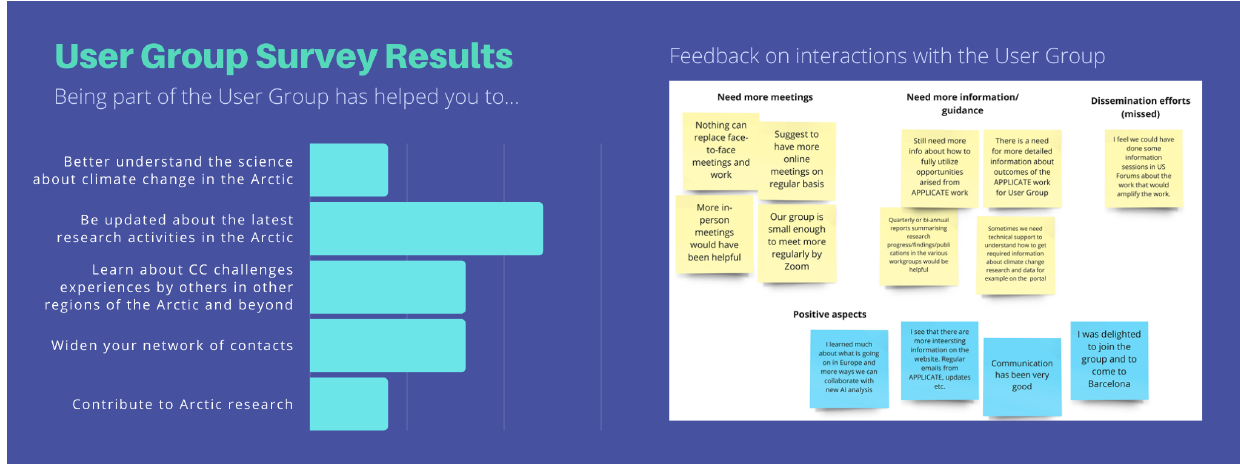
Figure 3. Main benefits of participating in the APPLICATE UG indicated by UG members. Sources of data and feedback have been collected and visualized by the team at the Barcelona Supercomputing Center